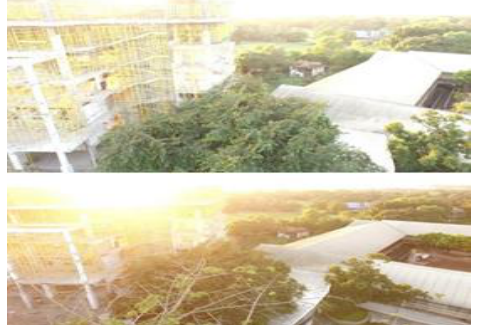
Figure 4. Sample blurred image (upper), sun’s glare (lower)